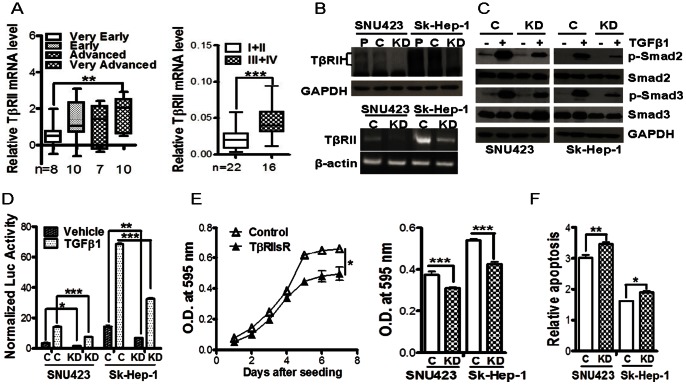
TβRII expression and its role in supporting HCC cell viability.(A) TβRII expression was compared in different stages of HCCs from ONCOMINE (left panel) and in 38 HCC tissue specimens by quantitative real-time RT-PCR (right panel). **, p<0.01; ***, p<0.001. (B) Western blotting analysis (upper panel) and RT-PCR (lower panel) showed decreased TβRII expression in TβRII knockdown HCC cells (KD) in comparison to the control vector-transfected cells (C) or parental cells (P). (C) SNU423 and Sk-Hep-1 cells with control and TβRII shRNA were treated with 2 ng/ml TGF-β1 for 1 hour. Immunoblotting analysis was performed for the levels of Smad proteins in cell lysates. (D) Control and TβRII shRNA cells were transfected with pSBE4-Luc and β-gal plasmids. Luciferase assay was done 24 hours after incubation with 2 ng/ml TGF-β1. β-gal-normalized luciferase units are presented as mean±SEM from three independent transfections. *, p<0.05; **, p<0.01; ***, p<0.001. (E) Cell proliferation was measured with MTT assay in control and TβRII-knockdown Sk-Hep-1 cells over a 7-day period (right panel) or on Day 5 after plating (left panel). Each data point represents mean ±SEM from four independent wells for Sk-Hep-1 and twelve independent wells for SNU423. A two-tailed paired T-test was performed to compare the two growth curves in the right panel. *, p<0.05; ***, p<0.001. (F) Effect of TβRII knockdown on apoptosis in SNU423 and Sk-Hep-1 cells. Cells were cultured in 60 mm dishes and harvested after 24-hour serum-deprivation at a density of 70–80% confluence. Each data point represents mean±SEM from three independent wells. *, p<0.05; **, p<0.01.